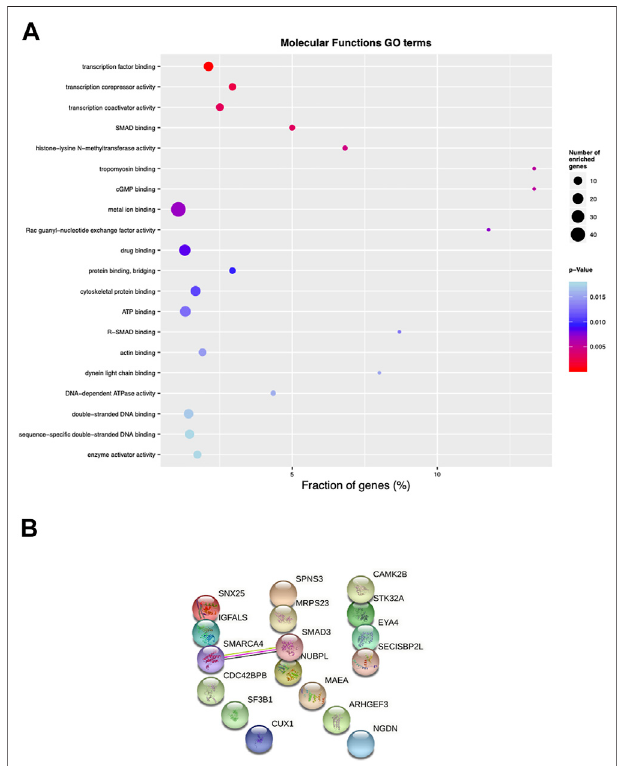
FIGURE7| Pathwayenrichmentandprotein-proteininteractionanalysis of psoriatic disease MZ twins. (A) Top 25 differentially enriched GO terms identi fi ed by the “ topGO ” Bioconductor tool, using the “ molecular functions ” database, ordered by elimFisher p value. The width of the dots indicates the percentage of the enriched genes out of the total number of genes belonging to each term. (B) protein-protein interaction analysis evaluated with stringdb